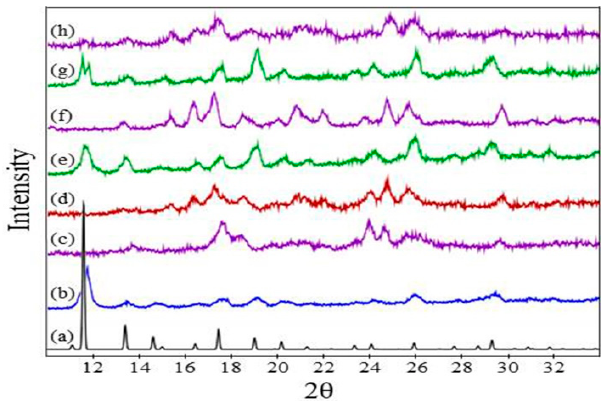
Figure 7. XRD patterns of ( a ) reference pattern for HKUST-1 powder (ICDD pdf number 00-062-1183); ( b ) commercially obtained HKUST-1 powder (Basolite ® C 300) before gas exposure; ( c ) after NH 3 exposure without activation; ( d ) after NH 3 exposure with prior activation; ( e ) after H 2 O vapor exposure; ( f ) after H 2 O vapor and subsequent NH 3 exposure without activation; ( g ) after DMSO exposure; ( h ) after DMSO and subsequent NH 3 exposure without activation.